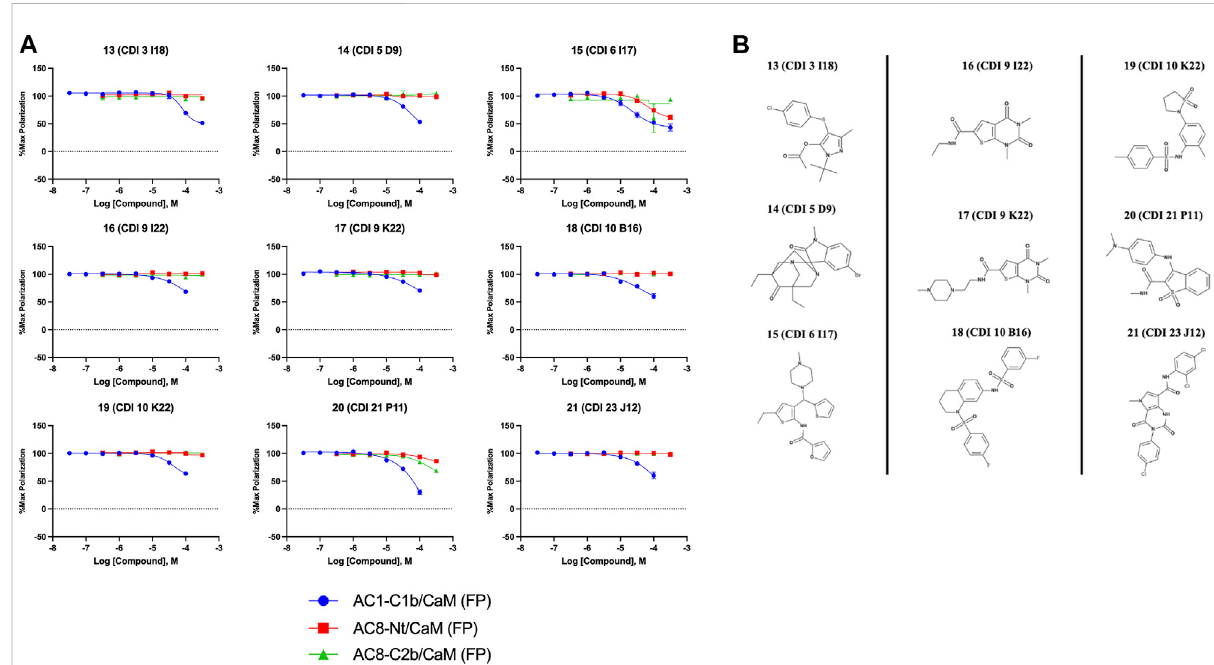
FIGURE 4 Concentration response curves (A) and structures (B) for the ChemDiv library hits. Each hit was used to generate CRCs in the AC1-C1b/CaM (blue circles), AC8-Nt/CaM (red squares), and AC8-C2b/CaM (green triangles) FP assays. (B) The structures for each hit are shown with the hit number and the given compound name. Data is normalized to vehicle (100% Maximum polarization) and 100 μ M CDZ (0% polarization). All data represents n = 3 experiments